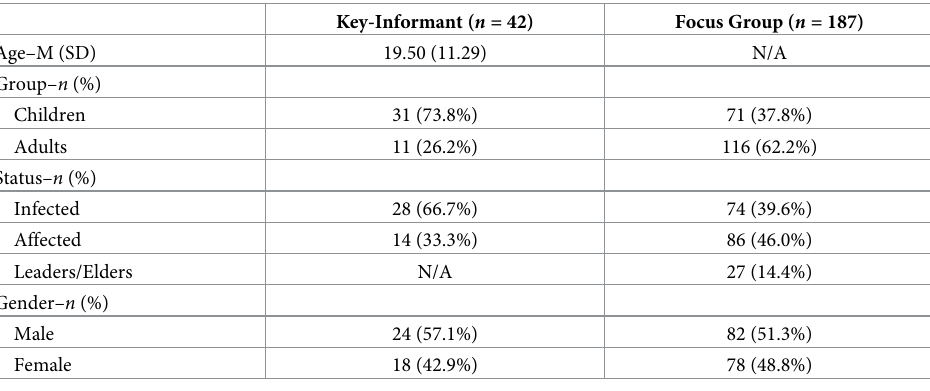
Table 1. Participant